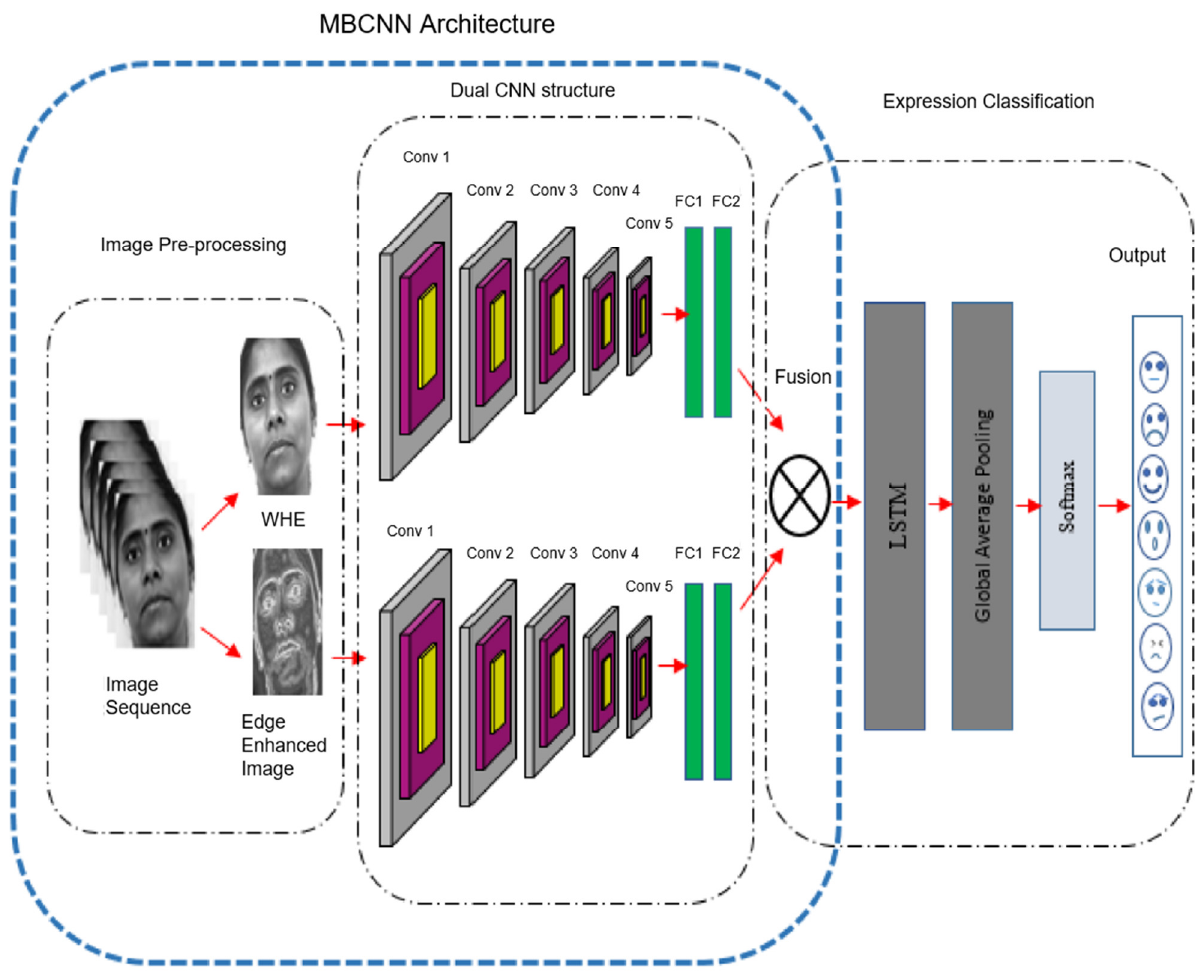
Figure 4. Proposed model for CNN+LSTM authentication [29].